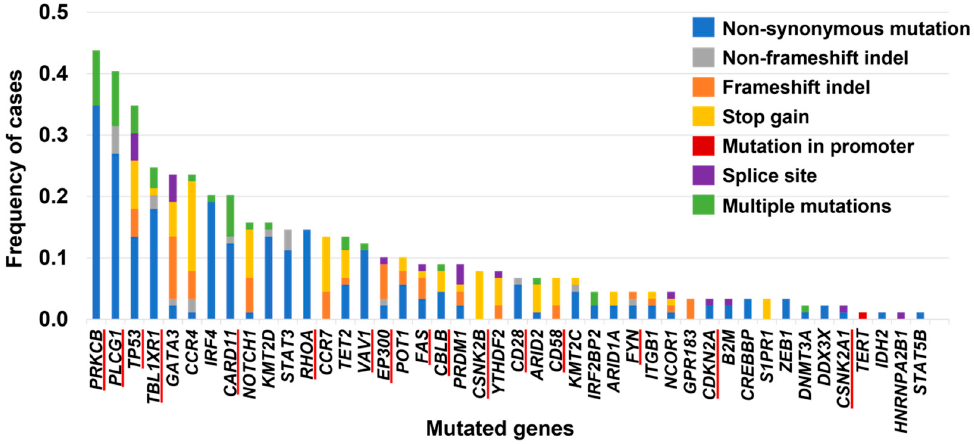
Figure 1. Mutated genes and their frequencies in aggressive ATLL identified in our previous study [17]. Genes underlined in red are part of the Tax interactome